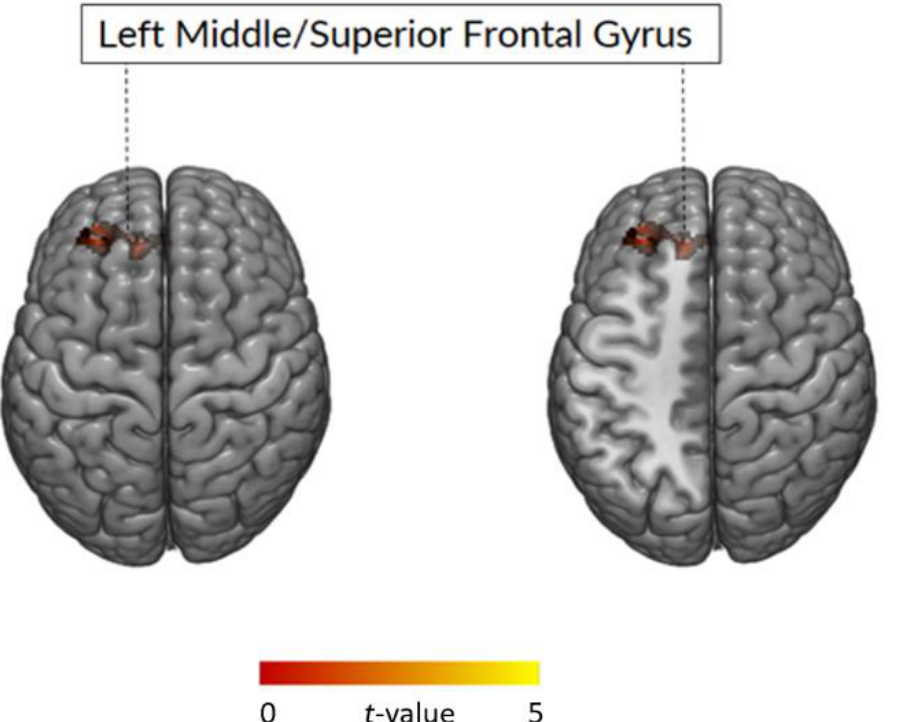
Figure 1. Whole Brain Analysis: BE > non-BE comparison. Results for the BE > non-BE comparison (MNI: − 26; 44; 35, Table 3). Statistical parametric maps are overlaid onto a Montreal Neurological Institute (MNI) template provided by the software MRIcroGL. The color-bar is representative of the t -scores reported in Table 3. Images are shown in neurological convention (i.e., left side of the image corresponds to the left side of the brain). Notes: BE = binge eaters; non-BE: non binge eaters. Table 3. Whole brain analysis: two sample t-test (covariates: age, gender and total intracranial vol- ume).